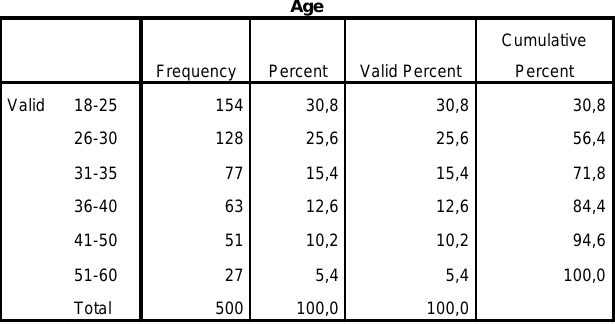
Table 1: Age Distribution